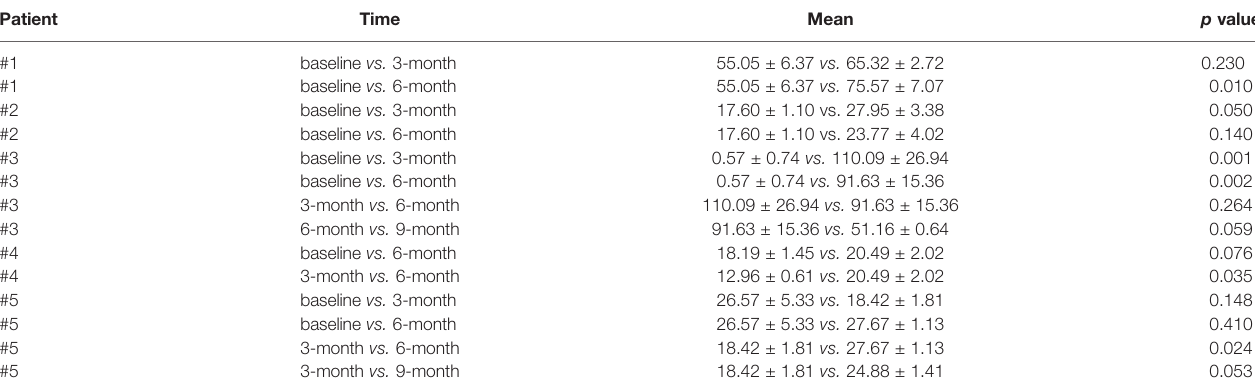
TABLE 1 | Comparisons of plasma cMLC-1 levels at different time points in trastuzumab-treated BC patients. Patient